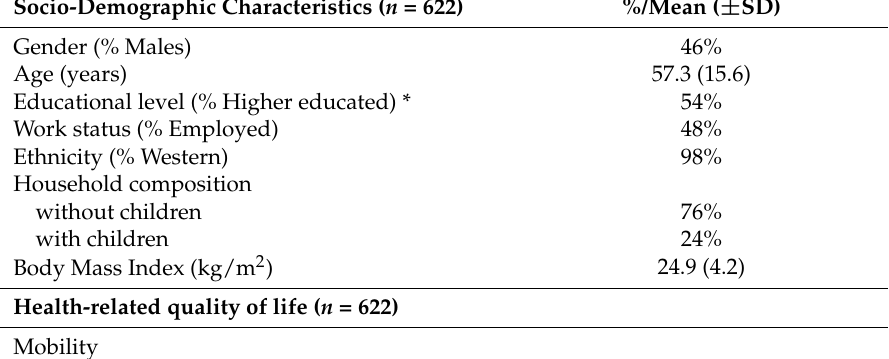
Table 1. Participants’